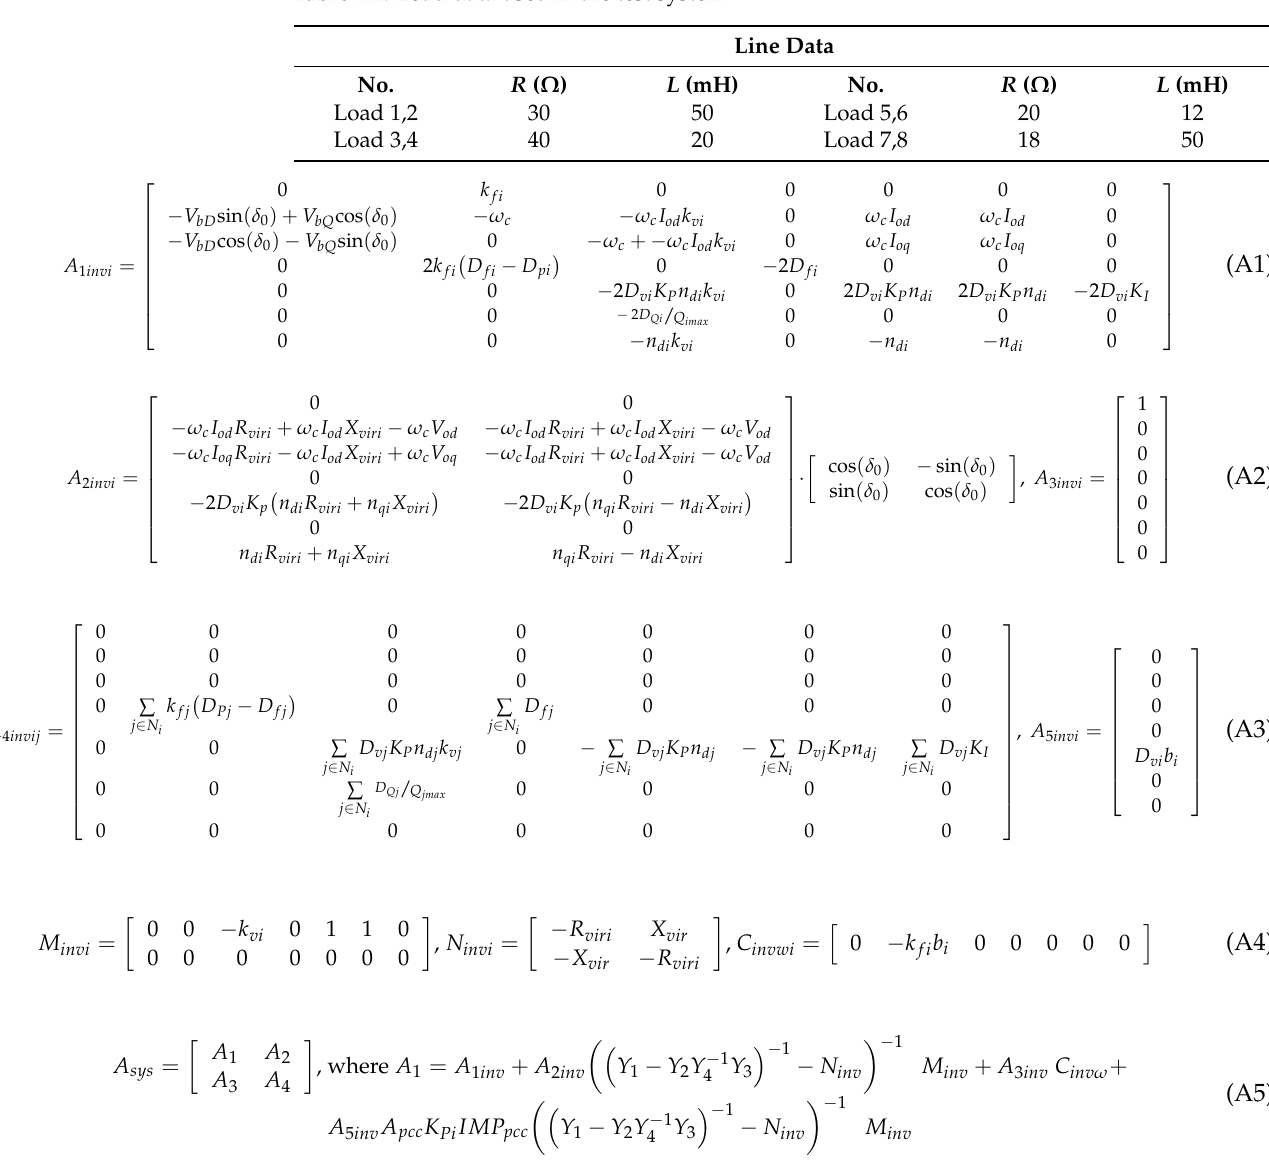
Table A4. Load data used in the test